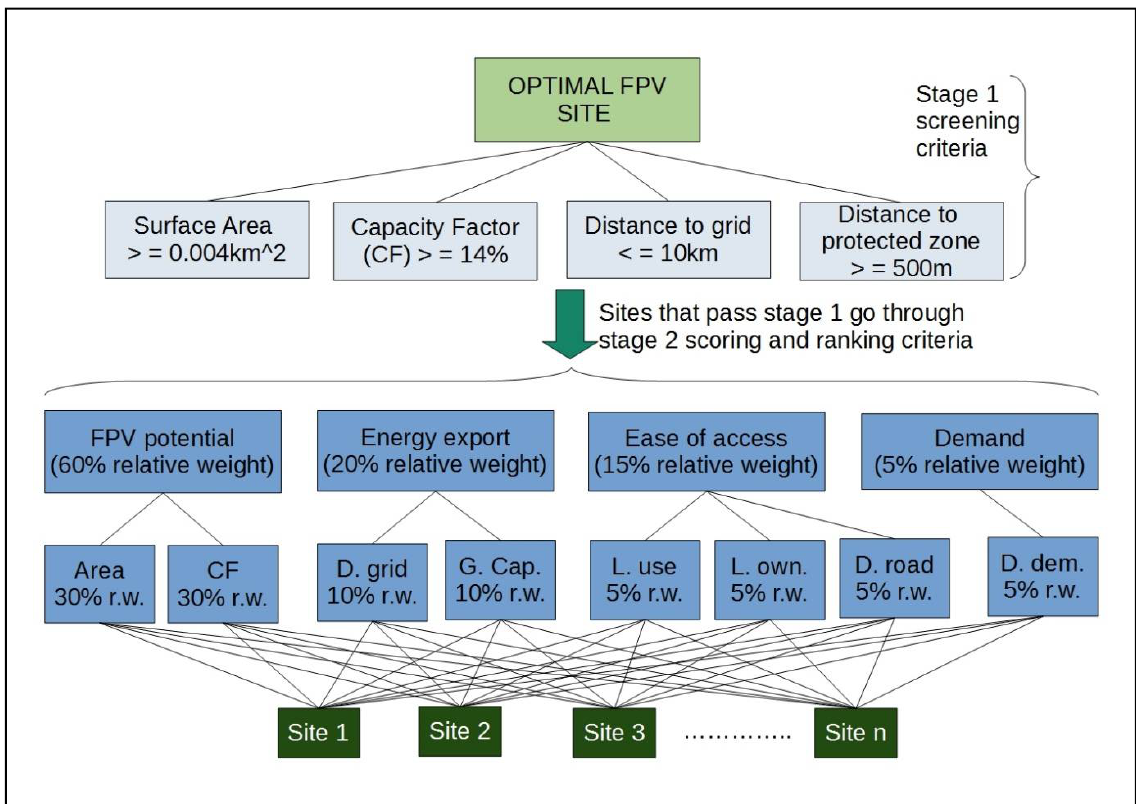
Figure 4. Diagram showing the proposed methodology flowchart of a 2-stage hierarchy structure for optimal floating photovoltaics site selection. Abbreviations: CF — capacity factor, D. grid — distance to grid, G. Cap. — capacity of grid, L. use — land use, L. own — land ownership, D. road — distance to road, D. dem. — distance to demand center, r.w. — relative weight.